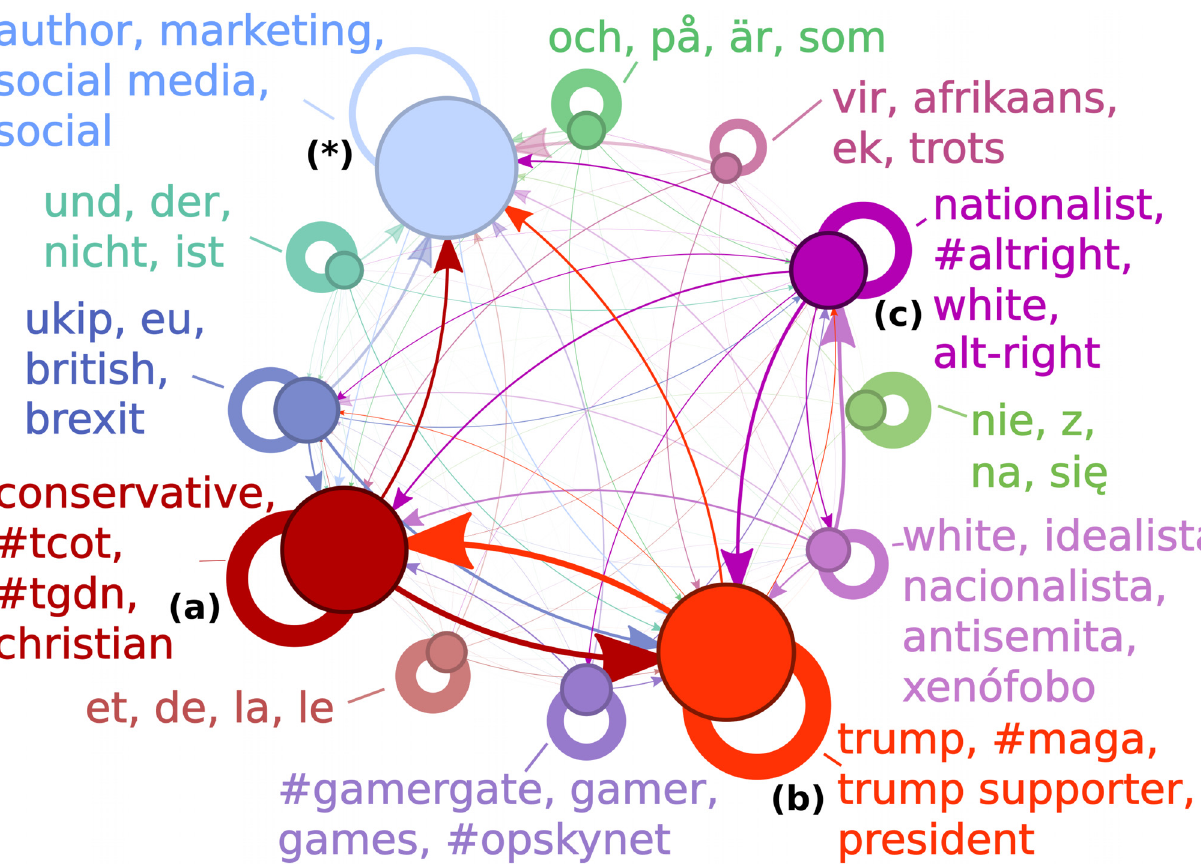
Fig 1. Map of far right groups sampled. We found three distinct groups of accounts associated with Trump’s campaign. These are emphasised with stronger colours: (a) GOP group, (b) Trump group, and (c) Alt-right group. The plot shows all groups ( > 2000 members) found by our sample linked according to how often their members follow accounts in other groups, and annotated with words used significantly commonly in the biographies of the group’s members. The thickness of links was calculated by recording, for each member of the originating-group, the proportion of accounts which were followed in the linked-group, and then taking an average of these proportions. Links are the same colour as the group containing the following accounts and point to the group containing the followed accounts. The most cohesive group (thickest self-loop) is the Trump group with an average member having 70% of the accounts they have followed being in the same group. The largest group was size 55,730, (marked �